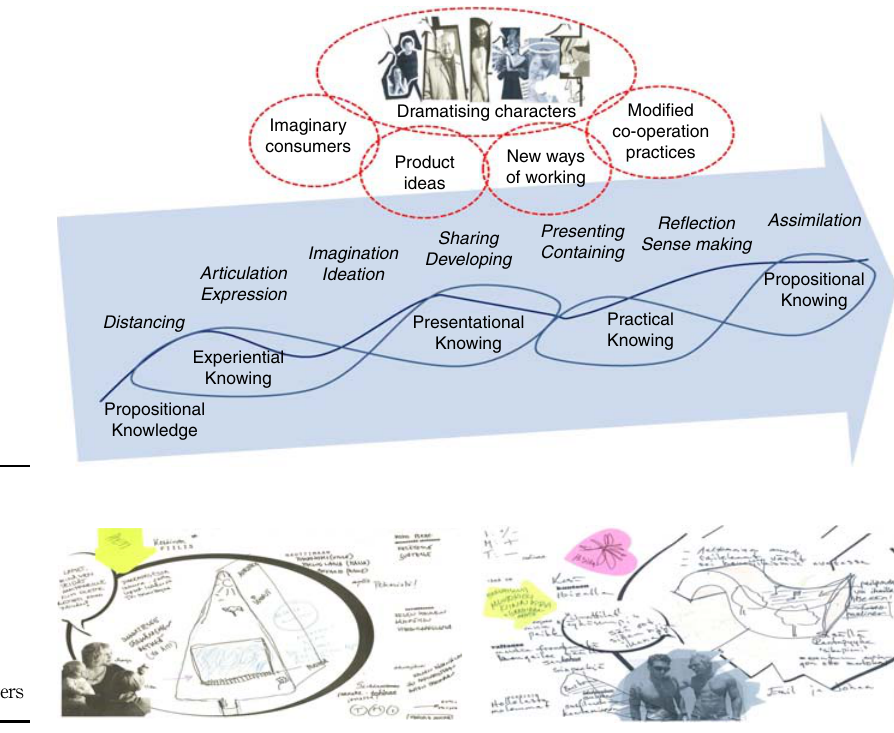
Figure 2. Examples of dramatised